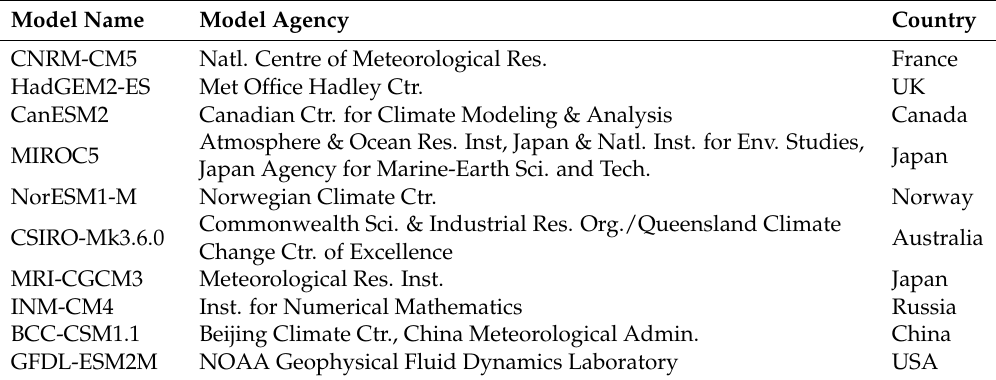
Table A1. Global climate models (GCM) used in this study. The ensemble mean was taken of all ten GMCs. MIROC5 and HadGEM2-ES were used for forest cover reduction